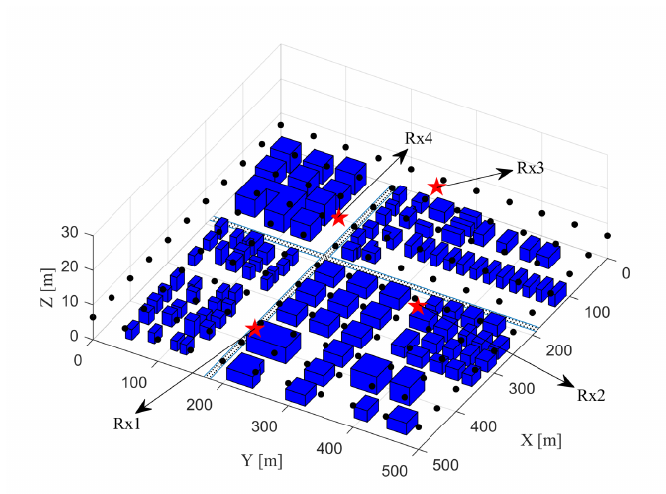
Figure 6. The area used for the verification of the propagation graph simulation of the proposed performance-evaluation approach. The 111 objects marked in blue are placed in this area.